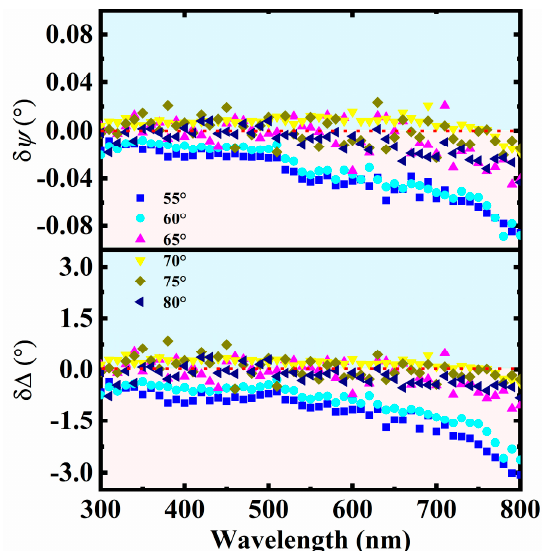
Figure 4. Discrepancies of the two sets of ellipsometric parameters at six incident angles in a spectral range.